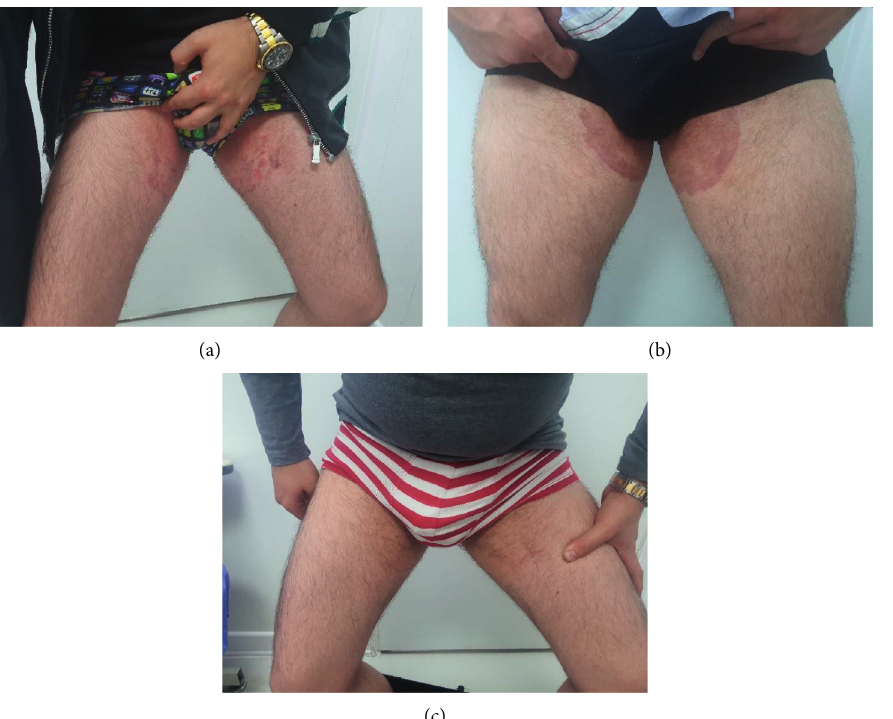
Figure 1: (a, b) Two patients with groin dermatophytosis which showed resistance to terbinafine; (c) sample of the same patients after treatment with